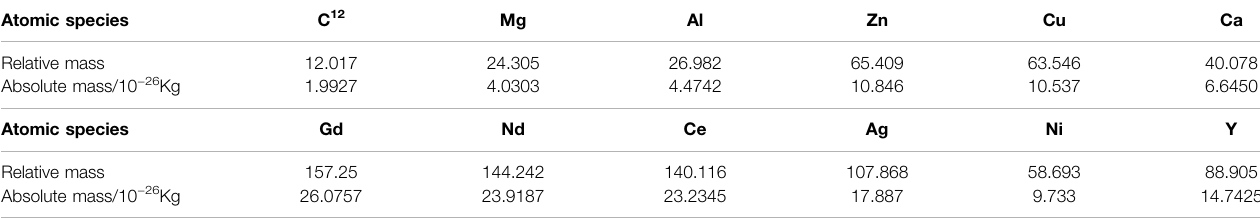
TABLE 1 | Absolute atomic mass of different alloying